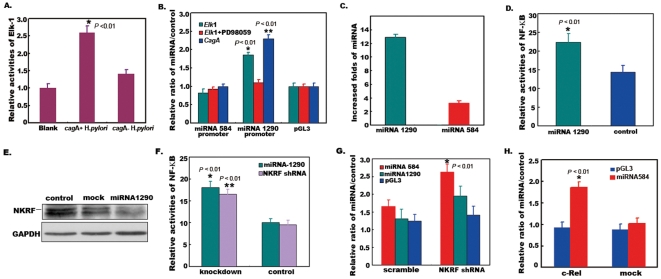
miRNA-1290 was up-regulated in an Erk1/2-dependent manner and miRNA-584 was activated indirectly by miRNA-1290. A. Determination of transactivities of Elk-1.AGS cells were transiently transfected with pGL3-Elk-1 plasmid for 24 h and subsequently infected with H.pylori including NCTC11637 and 7 cagA+ isolates for additional 7 h (MOI≈50) respectively. Cells were lysed and the lysates were collected for determination of luminescent intensities by dual-luciferase ÿreporter assay. The results showed that transactivities of Elk-1 was up-regulated after infection of cagA+ H.pylori (P <0.01, ANOVA). B. Determination of luciferase activations containing promoter region of miRNA-584 and miRNA-1290. Plasmids containing Elk-1 or cagA were co-transfected with recombinant luciferase reporters containing promoter regions of miRNA-584 and miRNA-1290 (≈2000 bp) respectively into 293T cells for 24 h (Elk-1/cagA: luciferase reporters: Renilla luciferase = 3∶1∶0.01). Cells were lysed and the lysates were collected for determination of luminescent intensities by dual-luciferase_reporter assay. The results showed that miRNA-1290 was up-regulated by both Elk-1 and CagA (P <0.01, ANOVA), whereas miRNA-584 was not affected. C. Determination of miRNA-584 in stable miRNA-1290–expressing cells. To determine miRNA-584 in stable miRNA-1290–expressing cells, total RNA from stable miRNA-1290–expressing cells were isolated and real-time PCR was performed for miRNA-584. The results showed that miRNA-584 was up-regulated in stable miRNA-1290–expressing cells. D. Expression of miRNA-1290 enhanced NF-κB activities. miRNA-1290 was co-transfected with NF-κB reporter into SGC7901 cells for 24 h (miRNA-1290: luciferase reporters: Renilla luciferase = 3∶1∶0.01). Cells were lysed and the lysates were collected for determination of luminescent intensities by dual- luciferase_reporter assay. The results showed that miRNA-1290 enhanced NF-κB activities (P <0.01, ANOVA). E. Detection of NKRF protein in transfected cells. miRNA-1290-expressing gastric carcinoma SGC7901 cells were lysed and subsequently were subjected to western blot analysis to probe with anti-NKRF antibodies. SGC7901 cells expressing the empty vector were also established as a control. F. Knockdown of NKRF increased NF-κB activities.
NKRF shRNA plasmid (Santa Cruz) was co-transfected with NF-κB reporters into SGC7901 cells for 48 h (NKRF shRNA plasmid: NF-κB reporters: Renilla luciferase = 3∶1∶ 0.1). Cells were lysed and the lysates were collected for determination of luminescent intensities. The results showed that knockdown of NKRF increased NF-κB activities (P <0.01, ANOVA). G. Activation of NF-κB upregulated miRNA-584.
NKRF shRNA plasmid was co-transfected with recombinant luciferase reporters containing promoter regions of miRNA-584 into SGC7901 cells for 48 h (NKRF shRNA plasmid: luciferase reporters: Renilla luciferase = 3∶1∶ 0.1). Cells were lysed and the lysates were collected for determination of luminescent intensities. The results showed that NF-κB up-regulated miRNA-584 (P <0.01, ANOVA). H. Overexpression of c-Rel upregulated miRNA-584.
c-Rel plasmid was co-transfected with recombinant luciferase reporters containing promoter regions of miRNA-584 into SGC7901 cells for 48 h (c-Rel plasmid: luciferase reporters: Renilla luciferase = 3∶1∶ 0.1). Cells were lysed and the lysates were collected for determination of luminescent intensities. The results showed that Overexpression of c-Rel upregulated miRNA-584 (P <0.01, ANOVA). Data are represented as mean +/− s.e.m.